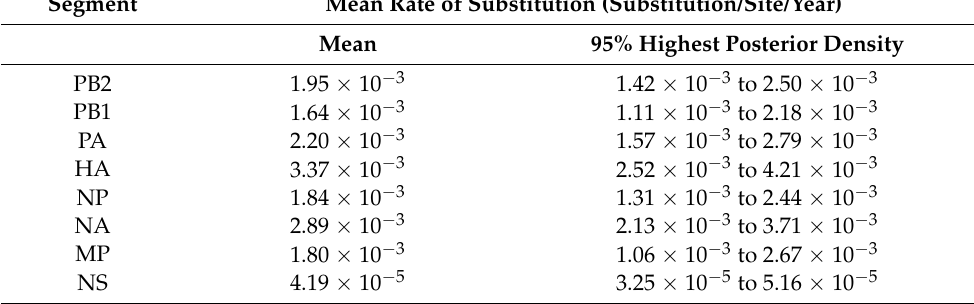
Table 2. Mean rates of nucleotide substitutions for all segments of A/H3N2 viruses circulating in Myanmar between 2015 and 2019. Segment Mean Rate of Substitution